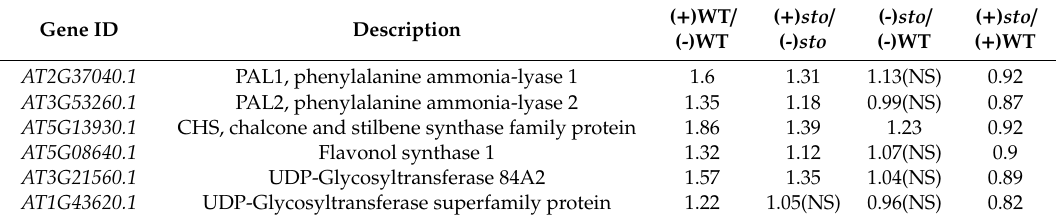
Table 3. Fold changes of flavonoid pathway proteins in di ff erent groups.